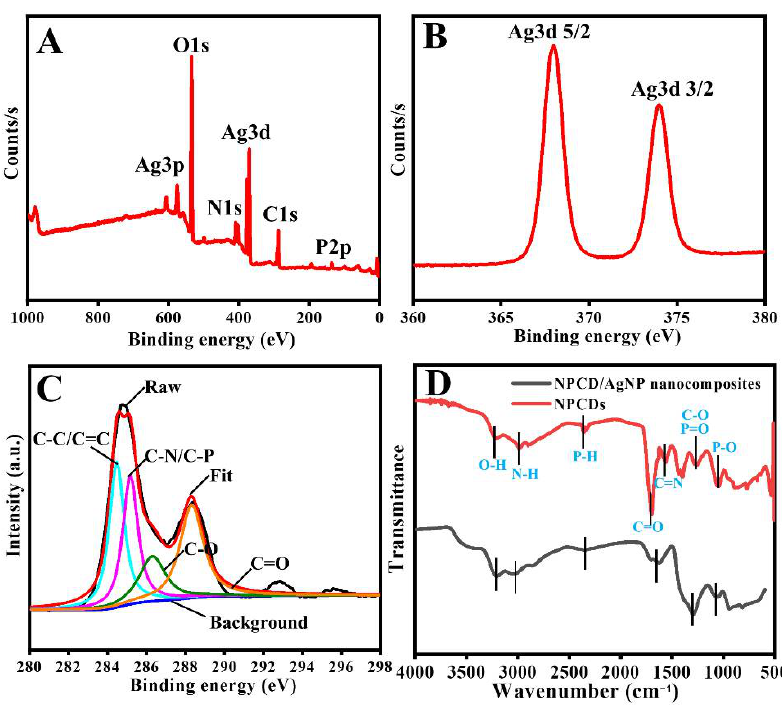
Figure 4. ( A – C ) XPS spectra of NPCD/AgNP nanocomposites. ( D ) FTIR spectra of the NPCDs and the NPCD/AgNP nanocomposites.